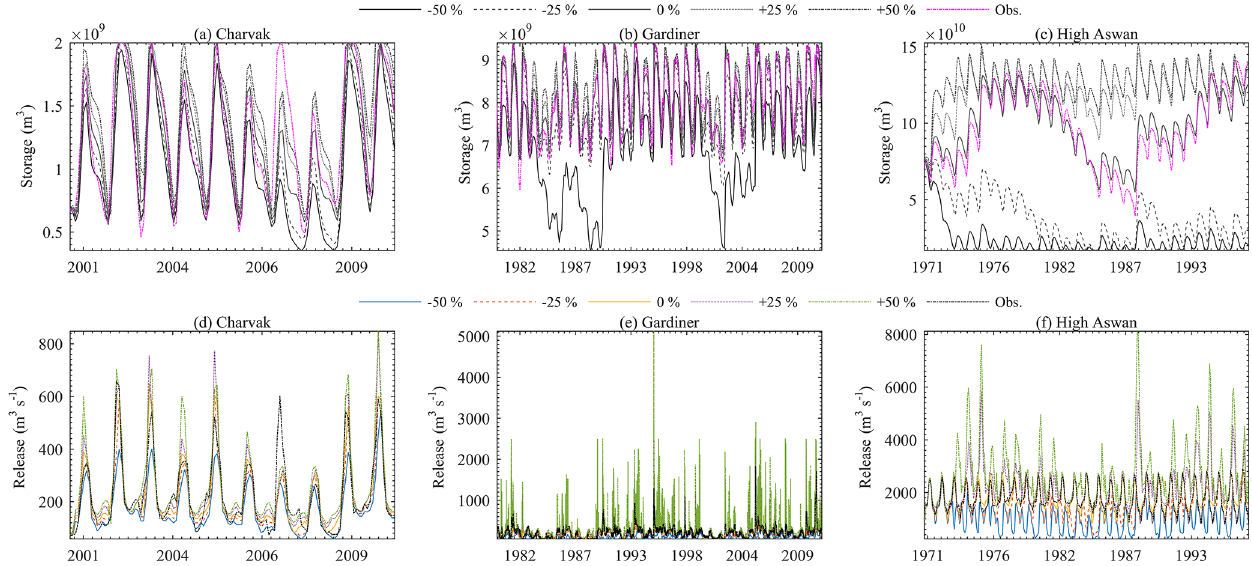
Figure 10. Inflow bias sensitivity test on storage and release simulation: (a) Charvak storage, (b) Gardiner storage, (c) High Aswan storage, (d) Charvak release, (e) Gardiner release, and (f) High Aswan release. Table 3. Inflow bias sensitivity test on storage and release